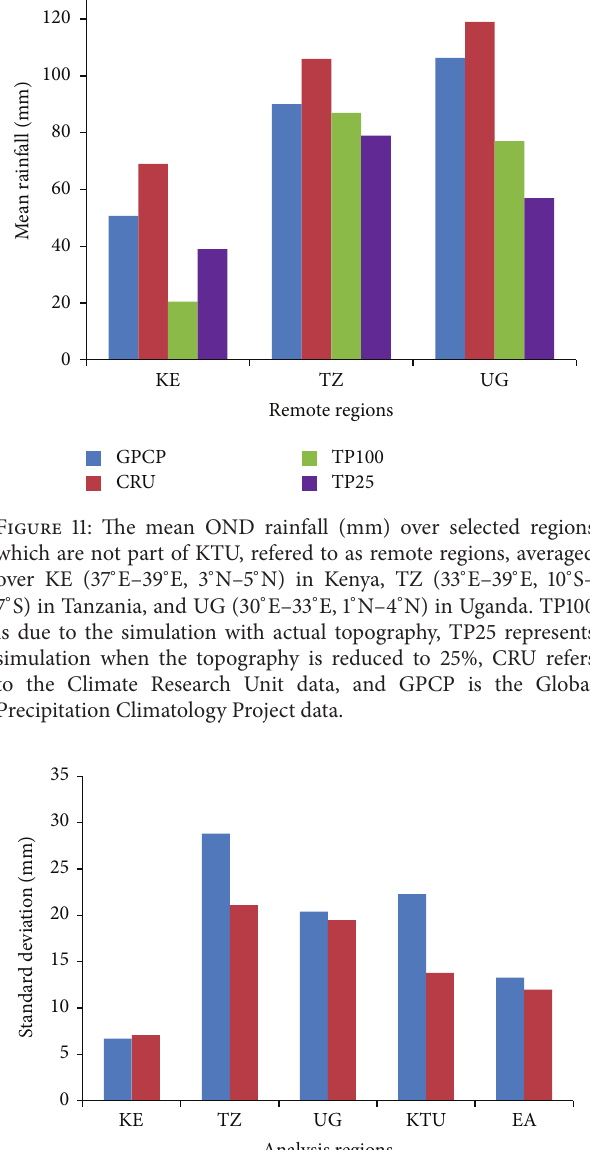
The interannual variability of OND rainfall over the east African region is influenced by KTU